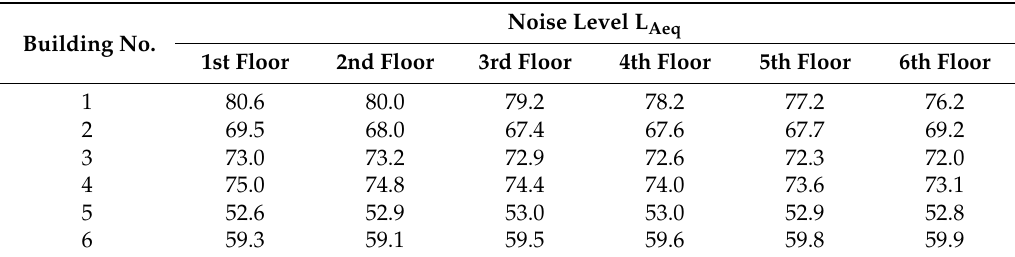
Table 5. Simulated noise levels in the surrounding buildings (unit: dB(A)).